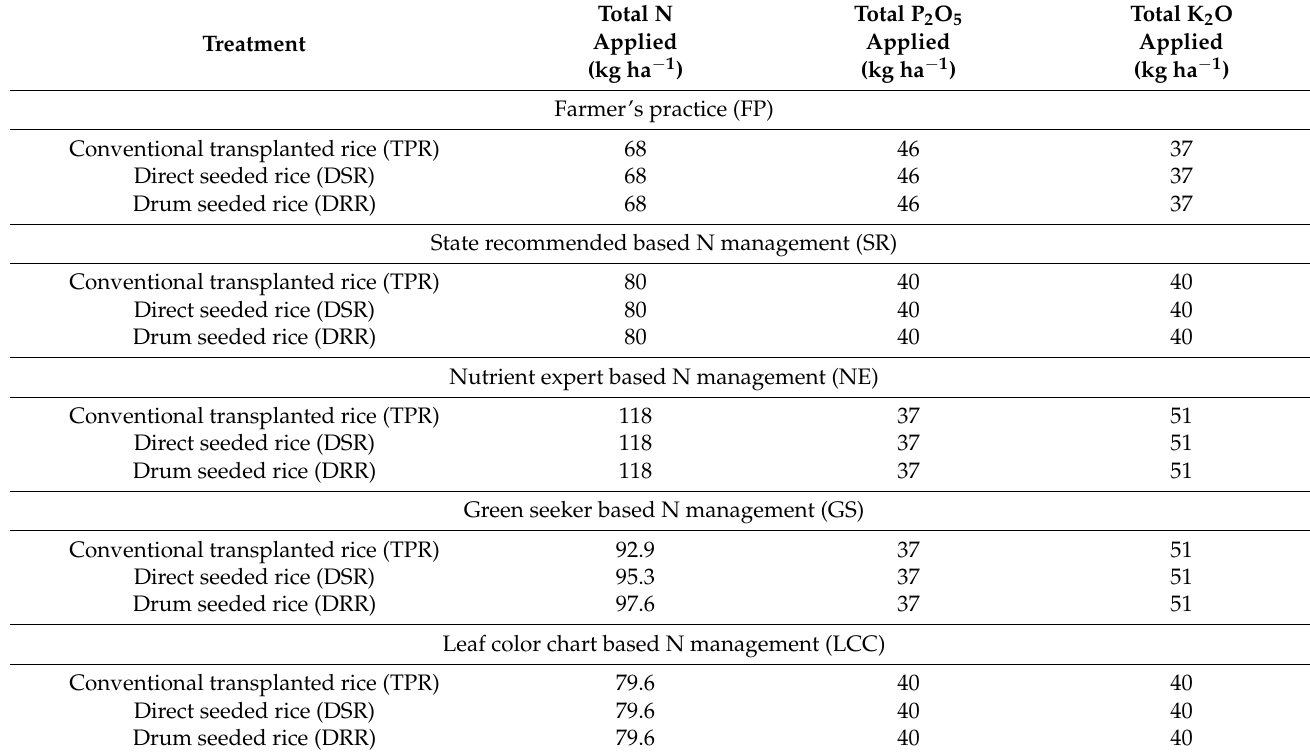
Table 2. Treatment wise N, P 2 O 5 and K 2 O application